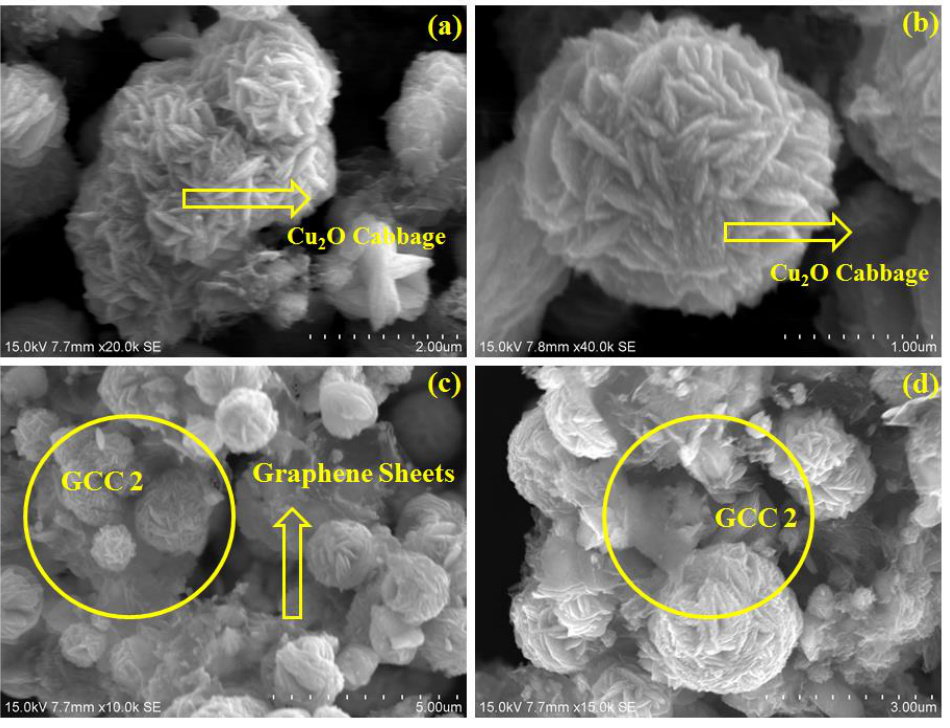
Figure 6. SEM pictures of ( a , b ) Cu 2 O and ( c – d ) GCC 2.